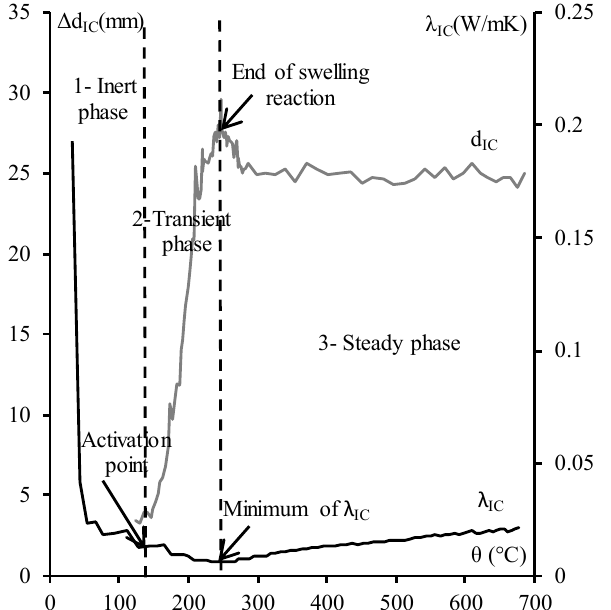
Figure 3. Common trends in the thermal equivalent conductivity and IC swelling and definition of the four general phases in their development.